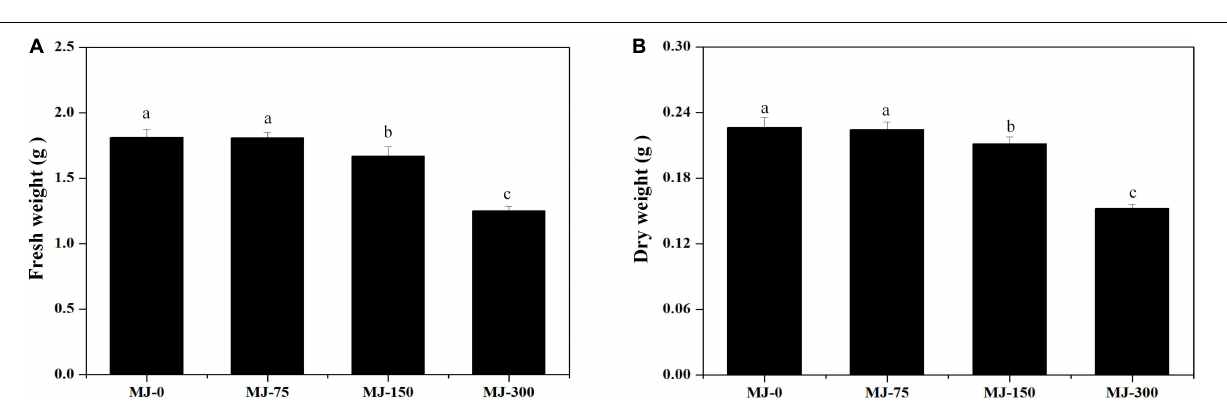
(100 mm × 2.1 mm, 1.8 µ m) were used to analyze